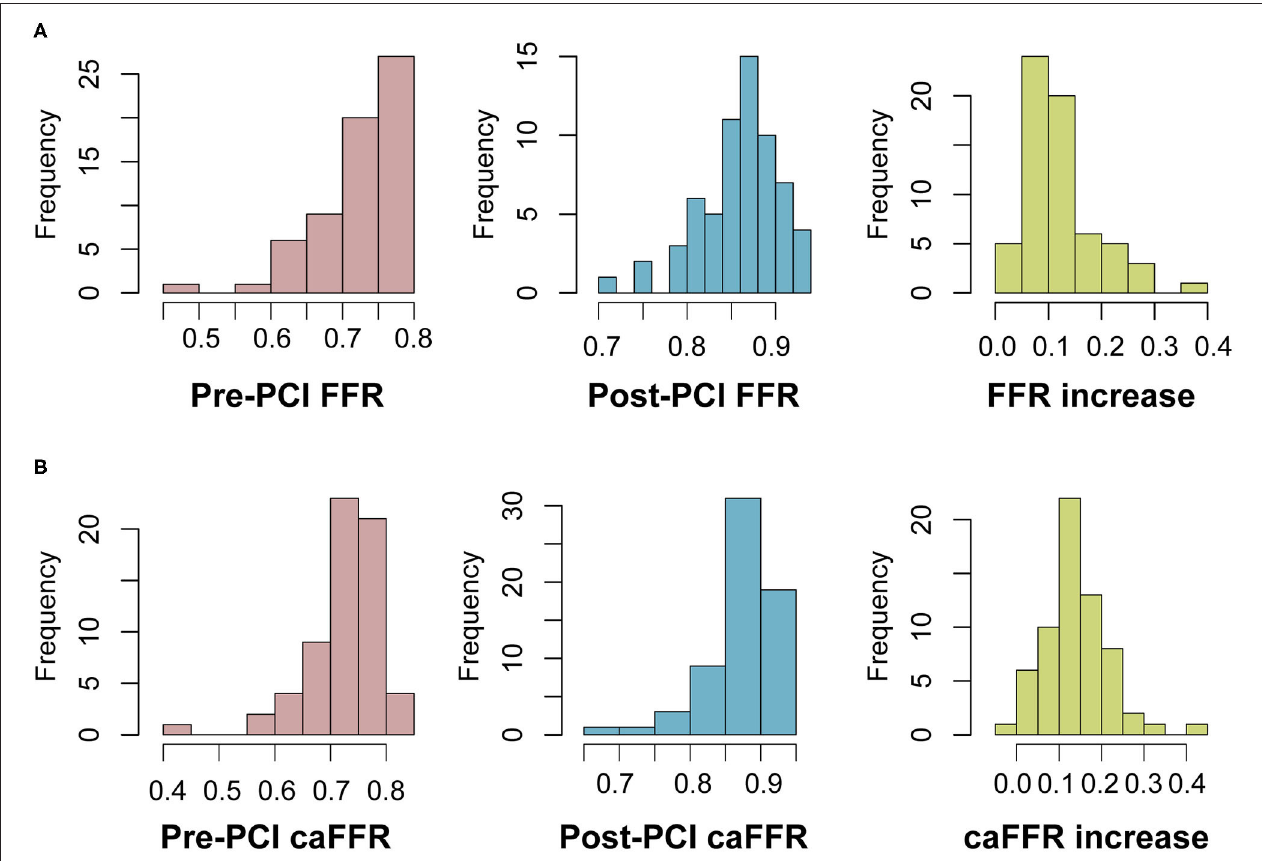
FIGURE 3 | Frequency distribution of FFR and caFFR values and increased values. (A) Frequency distribution and increased values of FFR. (B) Frequency distribution and increased values of caFFR. LAD, left descending artery; FFR, fractional flow reserve; PCI, percutaneous coronary intervention; caFFR, coronary angiography-derived